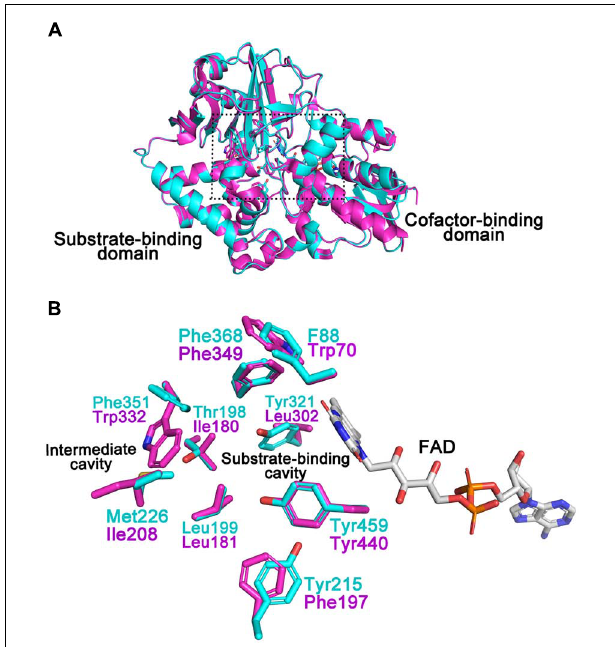
FIGURE 5 | Structural model of CHAO YT − 02 . (A) Superposition of the structural model of CHAO YT − 02 (magenta) and crystal structure of CHAO IH − 35A (cyan). A rectangular box indicates the putative positions, where the substrate and the cofactor are located. (B) Amino acid compositions of the substrate-binding and intermediate cavities. The carbon atoms in CHAO YT − 02 and CHAO IH − 35A are shown in magenta and cyan, respectively. The carbon atoms in FAD is presented in gray.